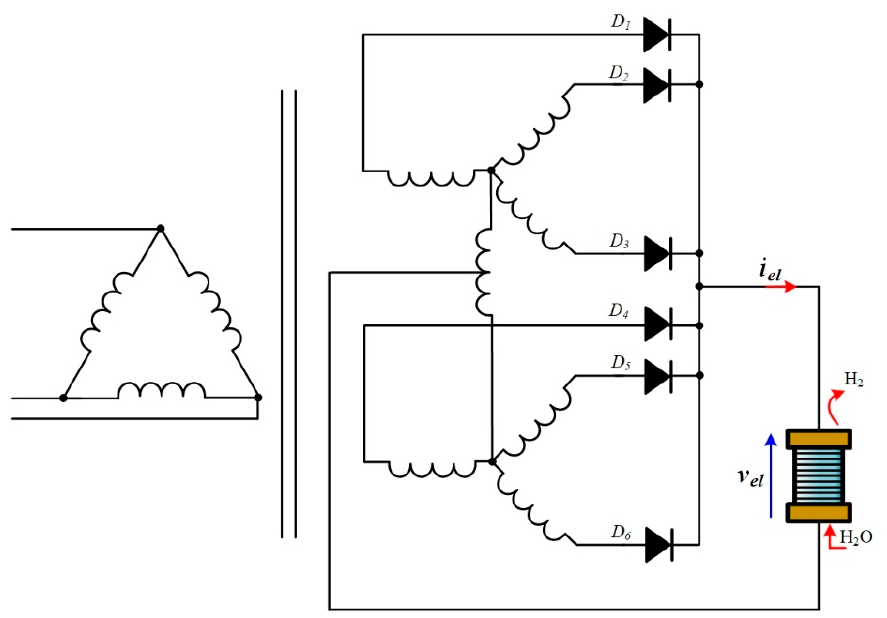
Figure 6. Six-pulse diode double-star rectifier.